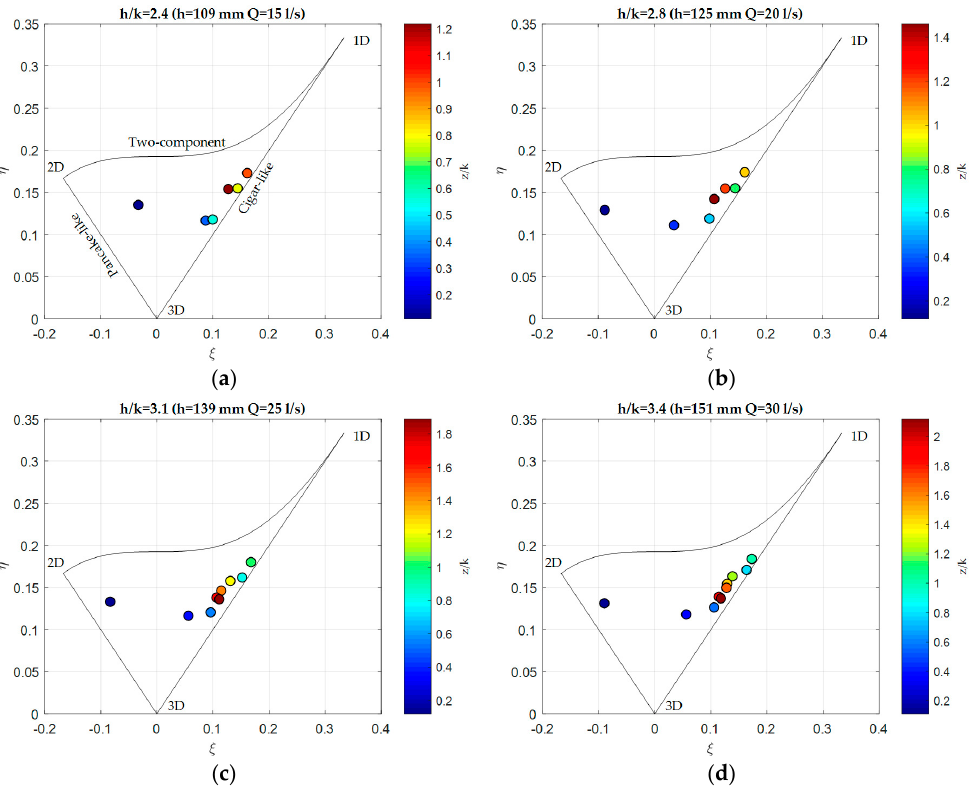
Figure 9. Invariant maps for turbulence componentality analysis for the different submergences: ( a ) 2.4; ( b ) 2.8; ( c ) 3.1; ( d ) 3.4.